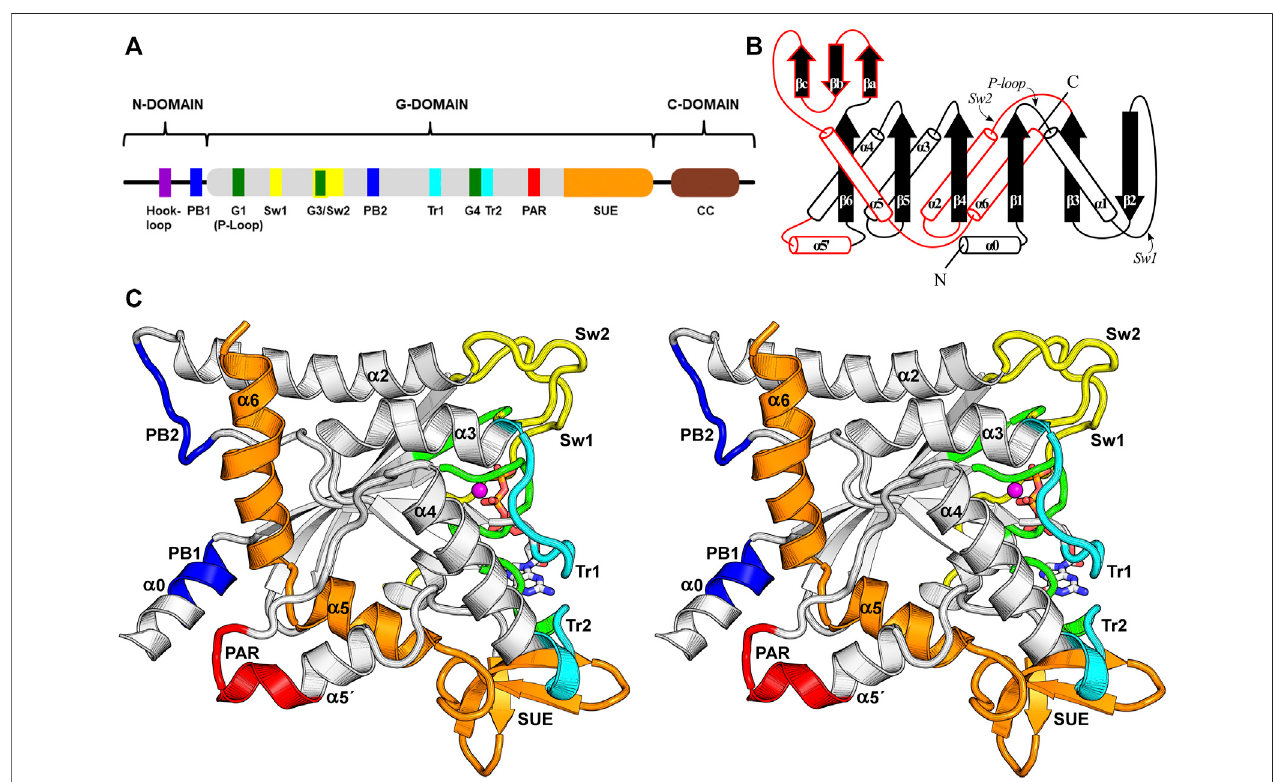
FIGURE 3 | The septin G-domain. (A) Schematic representation of the septin domains and their hallmark features. The N-domain presents variable length and encompassesthe α 0helix,whichcontainsthepolybasicregion1(PB1).TheG-domaincontainsalltheessentialnucleotide-bindingmotifs(G1,G3,G4)andtheswitches importantforcatalysis.Otherfunctionalelementsrelatedtointerfaceformation,suchasasecondpolybasicregion(PB2),apolyacidicregion(PAR),the trans -loops1and 2 (Tr1 and Tr2) and the septin unique element (SUE) are also indicated. The C-domain often contains heptad repeats that form coiled coils (CC). (B) A schematic topology diagram for the septin G-domain fold. Three unique features observed in septins are highlighted in red. (C) Stereo representation of the G-domain highlighting some of its features employing the same color code used in panel (A) . Several of these features and secondary structure elements are labeled. The PB1, PB2 and PAR are close to the NC-interface, while the switch I (Sw1), switch II (Sw2), Tr1 and Tr2 participate in the G-interface. The SUE is an exclusive feature of septins and participates in both interfaces. The Mg 2+ ion is coloured in magenta.